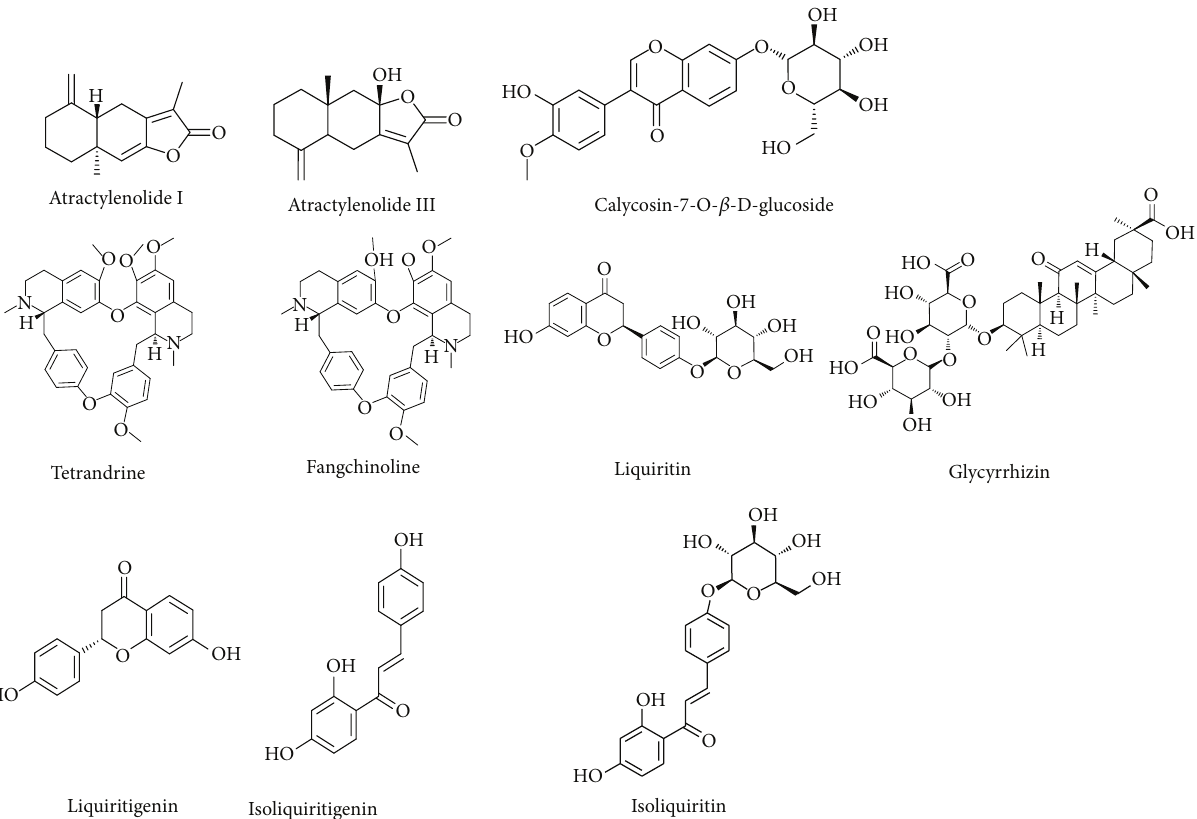
Figure 1: The chemical structures of the ten selected major compounds of FHT.